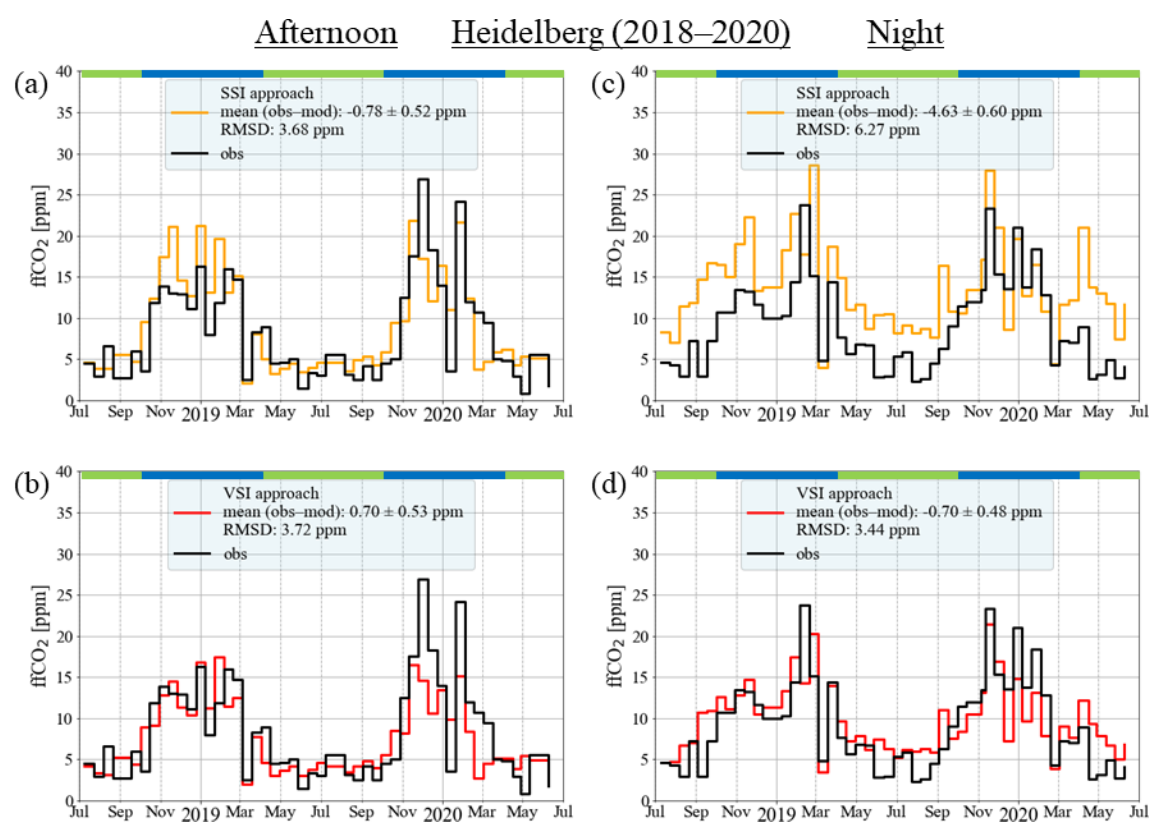
Figure 4. Comparison of 2-week integrated 14 C-based measured (black) and modelled (coloured) ffCO 2 concentration enhancements during afternoon hours (between 11:00 and 16:00UTC; a and b ) and during nighttime (between 18:00 and 06:00UTC; c and d ) for the time period of July 2018 until June 2020 in Heidelberg. The follow two modelling approaches were tested: the standard surface source influence (SSI) approach (orange; a and c ) and the volume source influence (VSI) approach (red; b and d ); see the text for further details. For each of the comparisons, the root-mean-square deviation (RMSD) between the model and observations, as well as the mean difference (observation minus model) and the standard error of the mean, are given. At the top of each panel the winter and summer periods are marked in blue and green,